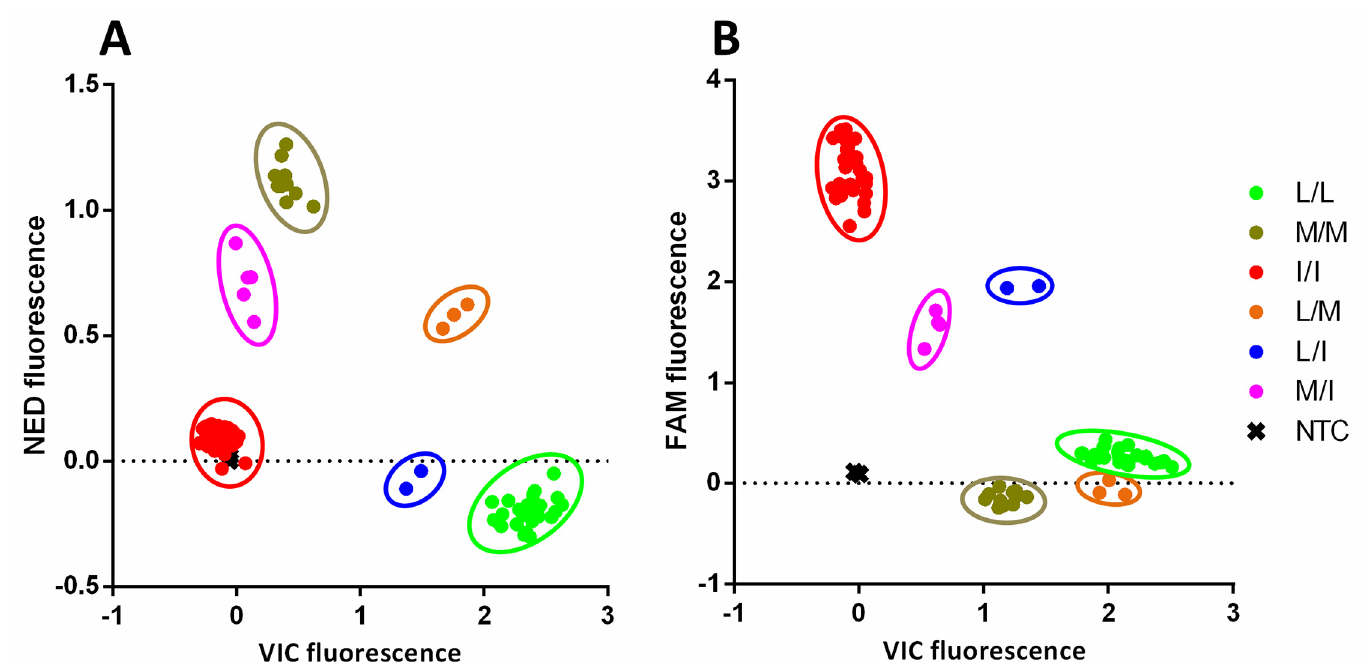
Fig 3. Result of an allelic discrimination TaqMan 1 assay for detection of mutations L925I and L925M in Varroa destructor VGSC. Scatter plot of fluorescence data from: A- NED 1 (M925 allele) vs VIC 1 (L925 allele) and B- 6-FAM ™ (I925 allele) vs VIC 1 (L925 allele), showing the distribution of the six possible genotypes given the three alleles present. L/L: Homozygous for Leucine, M/M: Homozygous for Methionine, I/I: Homozygous for Isoleucine, L/M: Heterozygous for Leucine and Methionine, L/I: Heterozygous for Leucine and Isoleucine and M/I: Heterozygous for Methionine and Isoleucine. Values of X and Y axes are final corrected fluorescence